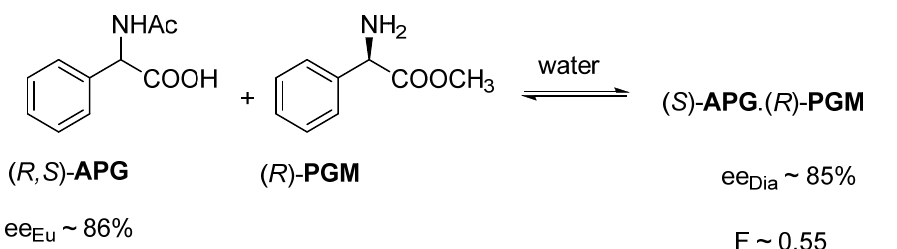
Figure 2. Binary melting phase diagram of a diastereomeric mixture of RR * and SR * [3,6] and the possibility of calculating the achievable F value using the ee Dia (Equation (2)).